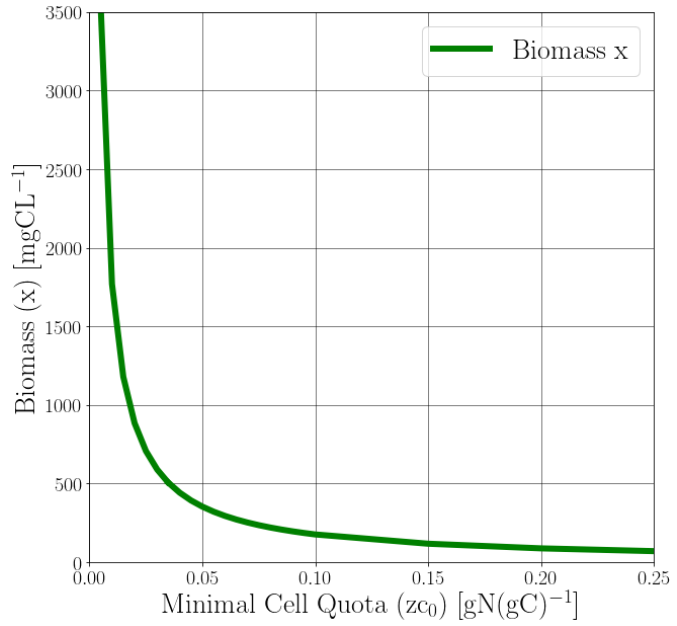
Figure 3. A bifurcation diagram of the biomass ( x ) vs. minimal cell quota ( zc 0 ). The horizontal axis of this figure indicates the values of th minimal cell quota zc 0 , and the vertical axis shows the values of biomass x . For each value of zc 0 , the diagram shows the corresponding equilibrium points. Parameters: ρ m = 0.0916 mgN ( mgC ) − 1 d − 1 , k s = 1.7499 mgNL − 1 , µ m = 1.8102 d − 1 , and zc 0 was varied from 0.01 to 0.25. Initial conditions correspond to x 0 = 91.483 mgCL − 1 , y = 14.5148 mgNL − 1 , z 0 = 0.0347 mgN ( mgC ) − 1 . Parameter data were obtained from [48]. We performed the simulation and plotting in Octave 5.1.0.0 and Python